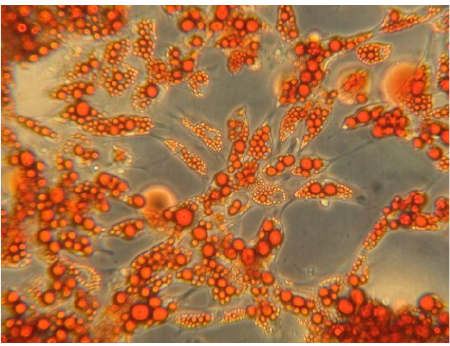
Figure 1 . Oil-red-O staining of mature human adipocytes differentiated in-vitro from stromal vascular fraction displaying cytoplasmic lipid droplets.